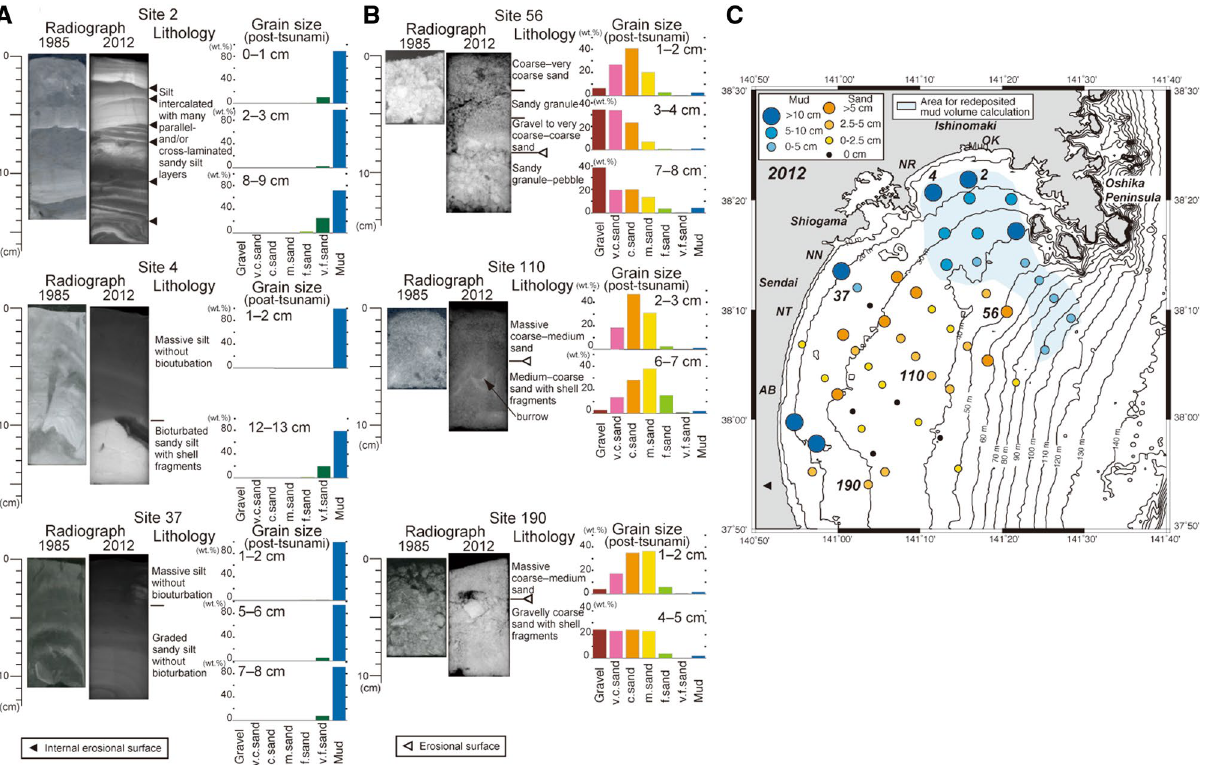
Figure 3. Comparison of sedimentary structures of the 1985 and 2012 sample, and description and grain-size distribution of 2012 subcore sample ( A , B ), and thickness of the upper homogeneous mud and sand ( C ). Sites 2 and 4 from the NISM, and 37 from the NWISM, Sites 56, 110 and 190 from the